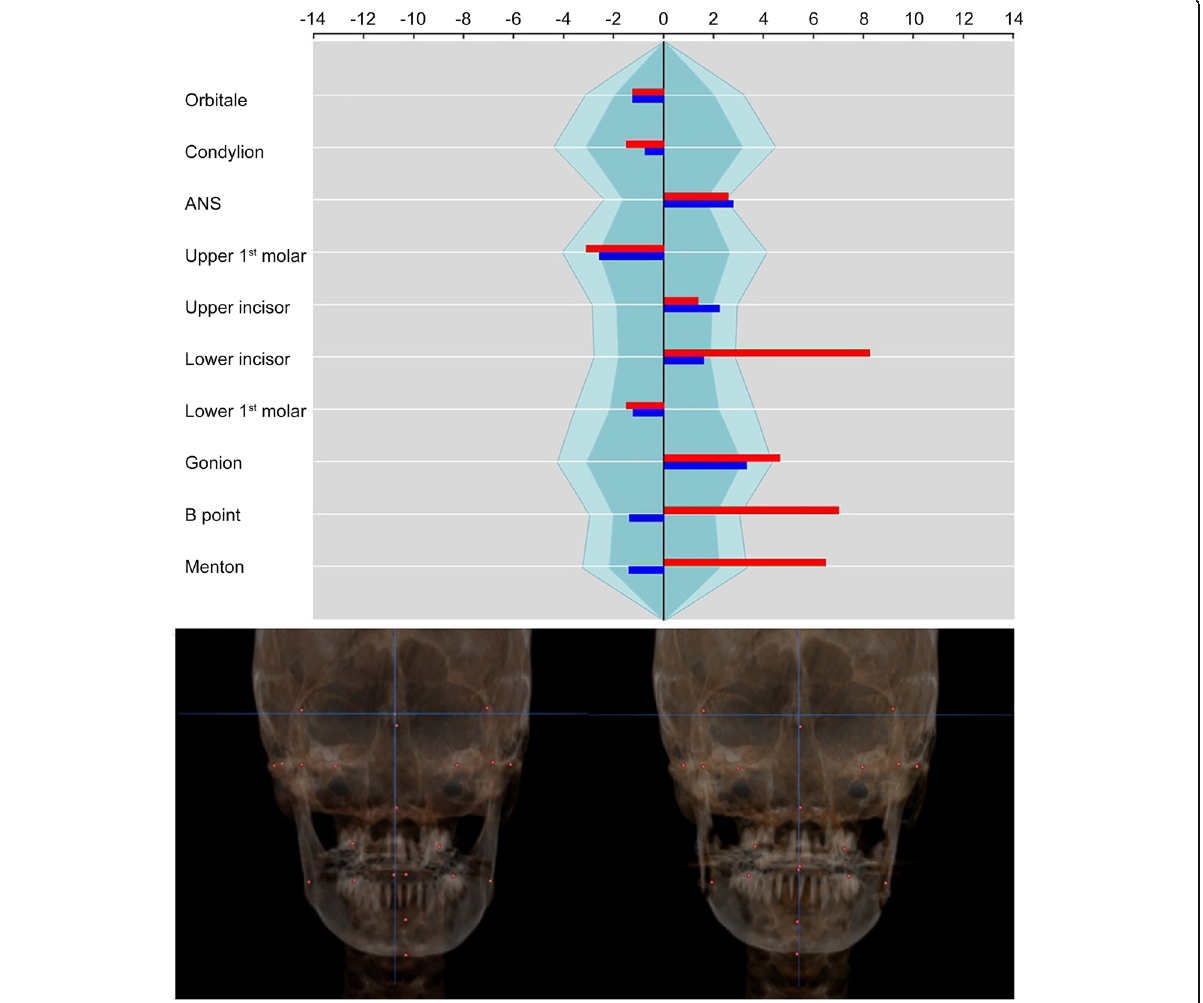
Fig. 6 Polygonal chart and 3D reconstruction images of case 1. The asymmetry index on orbitale was not changed because the 3D coordinate data of reference landmarks were maintained on the postoperative images. Asymmetry indices on maxillary landmarks almost did not change because the maxillary surgery did not include the canting correction or midline correction. Asymmetry indices on mandibular landmarks were greatly improved (red: before surgery, blue: after